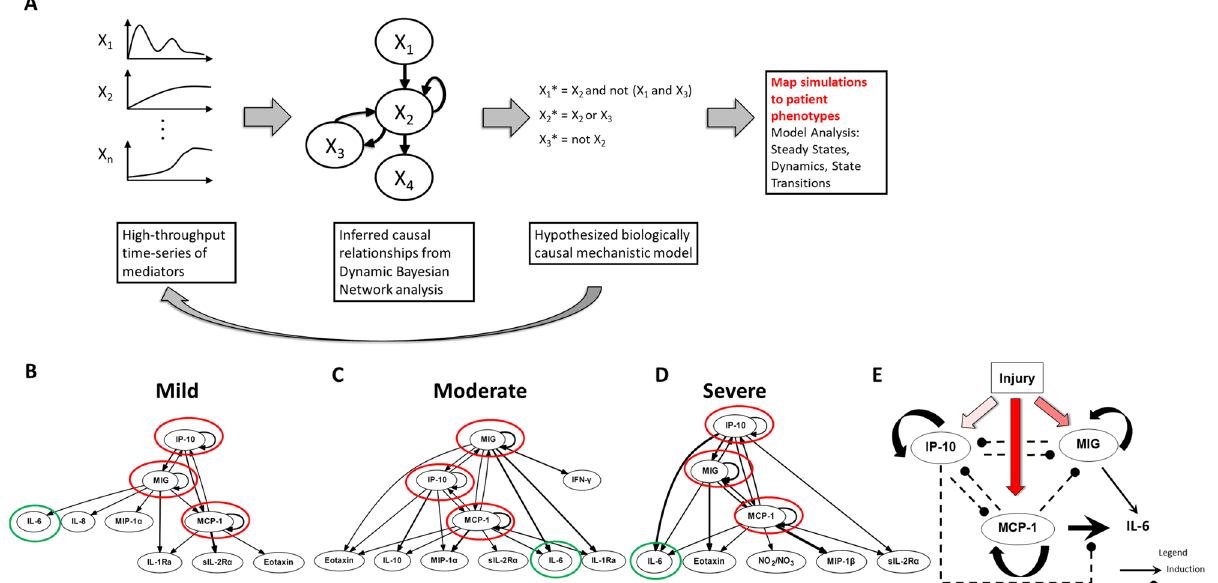
Figure 1. Workflow leading to a conceptual model of the “chemokine switch”. (Panel A ): A schematic of the analysis workflow. Time courses of inflammatory mediators were measured in trauma patients and causal interactions inferred by DyBN analysis. The inferred network topology formed the basis a Boolean model which was simulated in silico. Results were compared to clinical trajectories to refine the model. (Panels B-D ): DyBN consensus network structure for Mild, Moderate and Severe Injury. Panel E : Boolean model structure with cross-regulation among chemokines MIG, IP-10, and with cross-regulation among them and with the cytokine IL-6 as a shared output node (Fig. 1B-D) 20 . Notably, IL-6 levels generally correlate with injury severity and adverse outcomes such organ dysfunction, and there- fore serve as an excellent marker for the magnitude of the systemic inflammatory response and risk for organ dysfunction 9,22 . We note that several inflammatory mediators were significantly different by ANOVA between the moderate and severe injury patient sub-groups (Figure S1) but were not identified as nodes in the DyBN